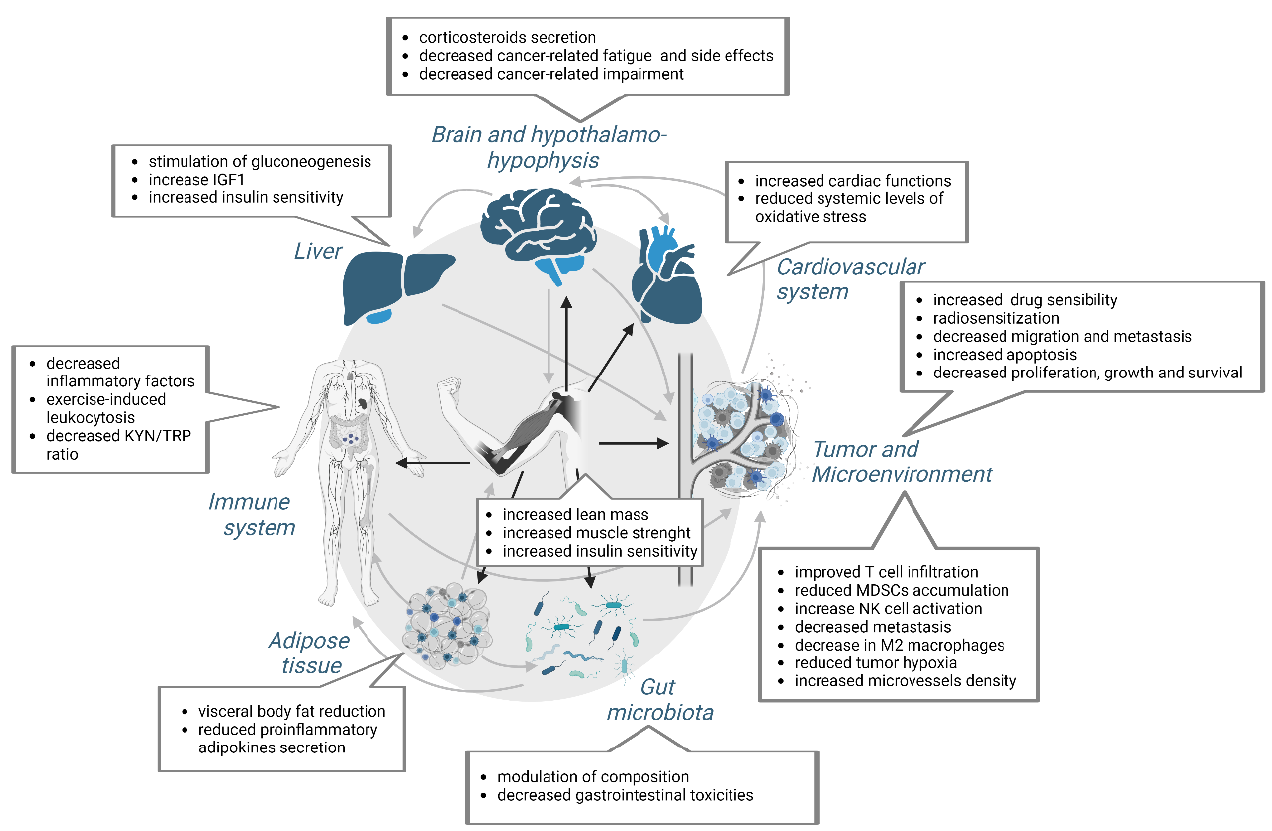
Figure 5. Emerging views of the muscle crosstalk with other organs (brain, hypothalamo-hypophysis, liver, immune system, adipose tissue, gut microbiota, cardiovascular system and tumor and its microenvironment) during the APA leading to mostly, but not exclusively, the anti-tumoral consequences. Created with BioRender.com.